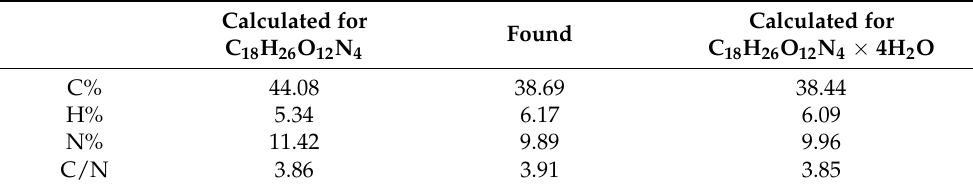
Table 1. Elemental analysis report for